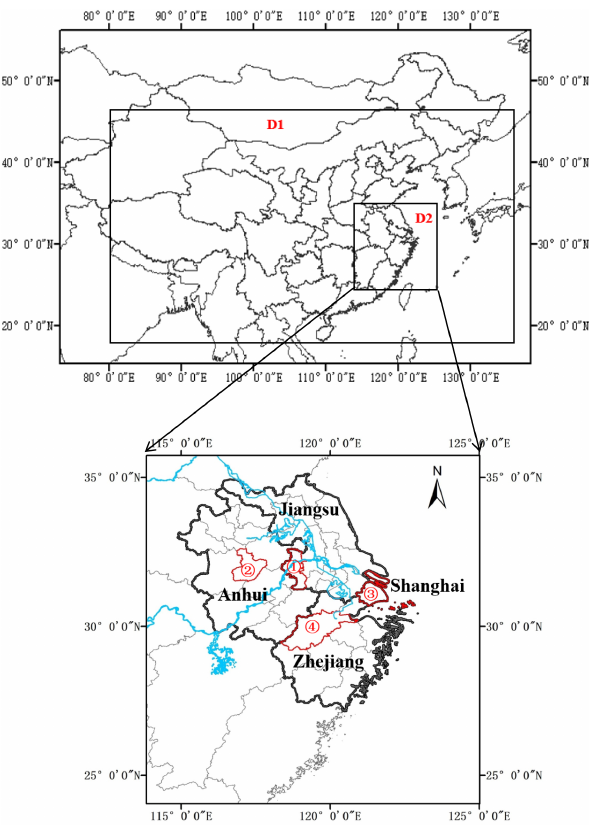
Figure 1. The modeling domain and the locations of the concerned provinces and their capital cities. The numbers 1–4 represent the cities of Nanjing, Hefei, Shanghai, and Hangzhou, respectively. The map data, provided by the Resource and Environment Data Cloud Platform, are freely available for academic use (http://www.resdc. cn/data.aspx?DATAID=201, last access: 19 April 2021), © Insti- tute of Geographic Sciences & Natural Resources Research, Chi- nese Academy of